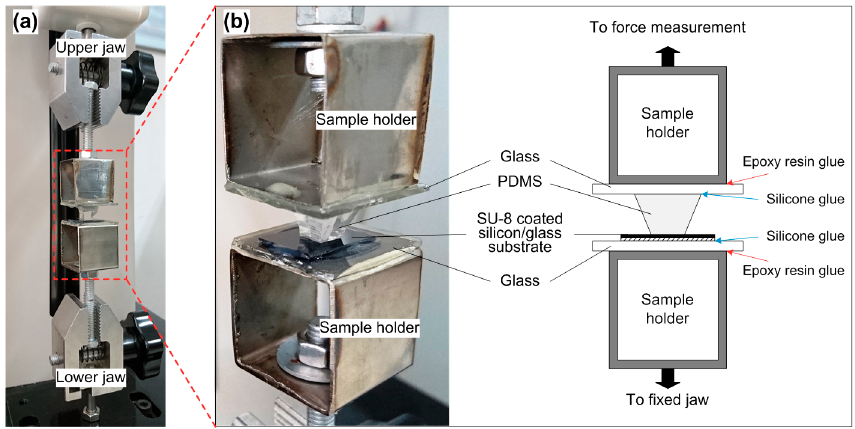
Figure 2. Setup of the tensile strength test. ( a ) Setup of the tensile tester. It has an immobile jaw at the lower position and a movable jaw connected to a force sensor at the upper position. The sample is fixed on the jaws through screws; ( b ) assembled sample in the tester. The sample holders were